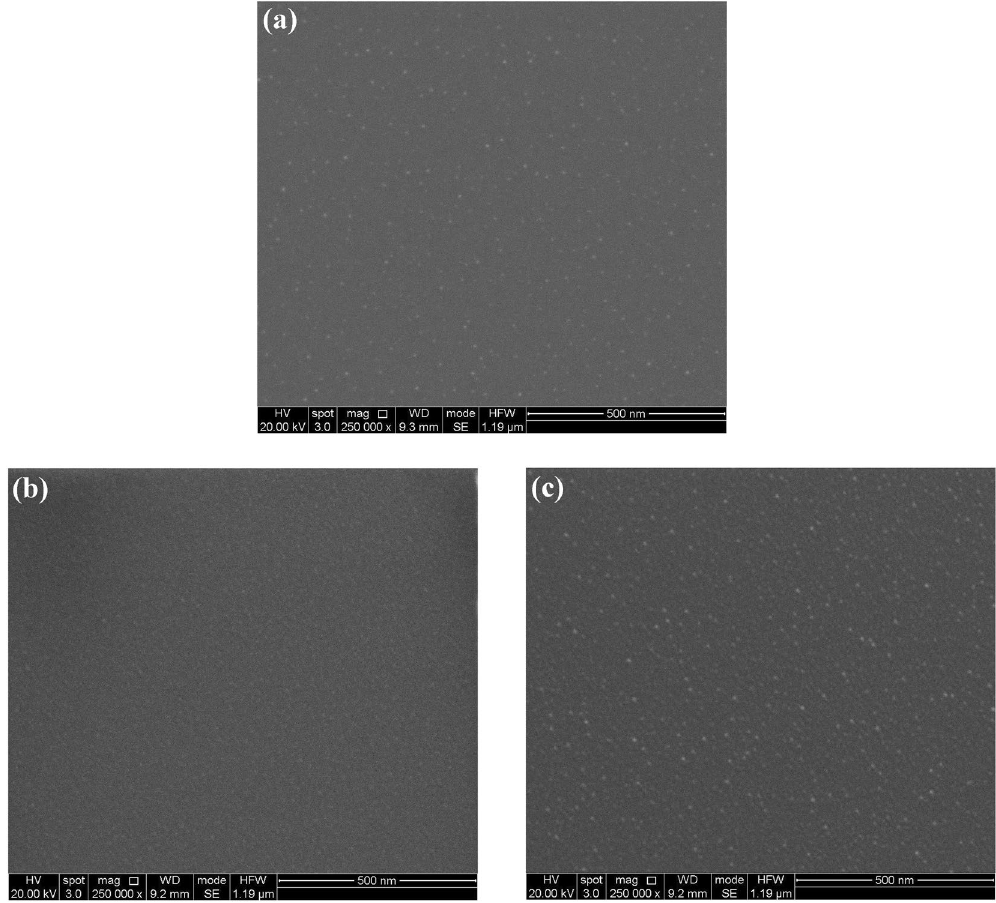
Figure 4. SEM images of B 4 C-coated test wafers taken at 20 kV electron acceleration voltage with a 250 k-fold magnification: ( a ) Pristine B 4 C-coated test wafer, ( b ) O 2 /Ar-plasma cleaned – formerly a-C coated part, and ( c ) O 2 /Ar-plasma cleaned – non a-C coated